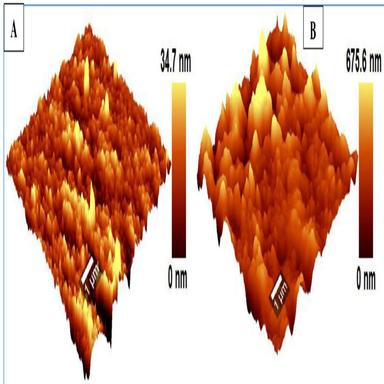
(a) AFM contact mode image of Ppy-GAC nanocomposite, and (b) the same image with an overlay of Ppy nanoparticles component Raman image (blue) of the Ppy-GAC nanocomposite sample.